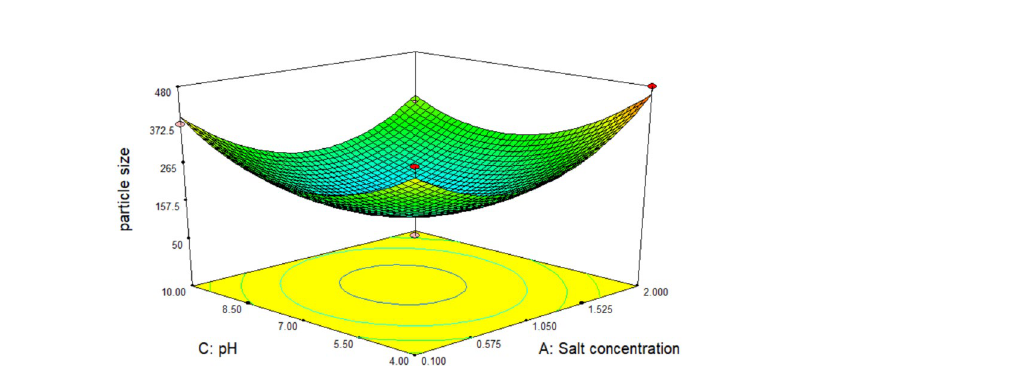
Figure 13. 3-D. Response surface plot showing the interaction between the pH and salt conc. and its effect on the produced particle